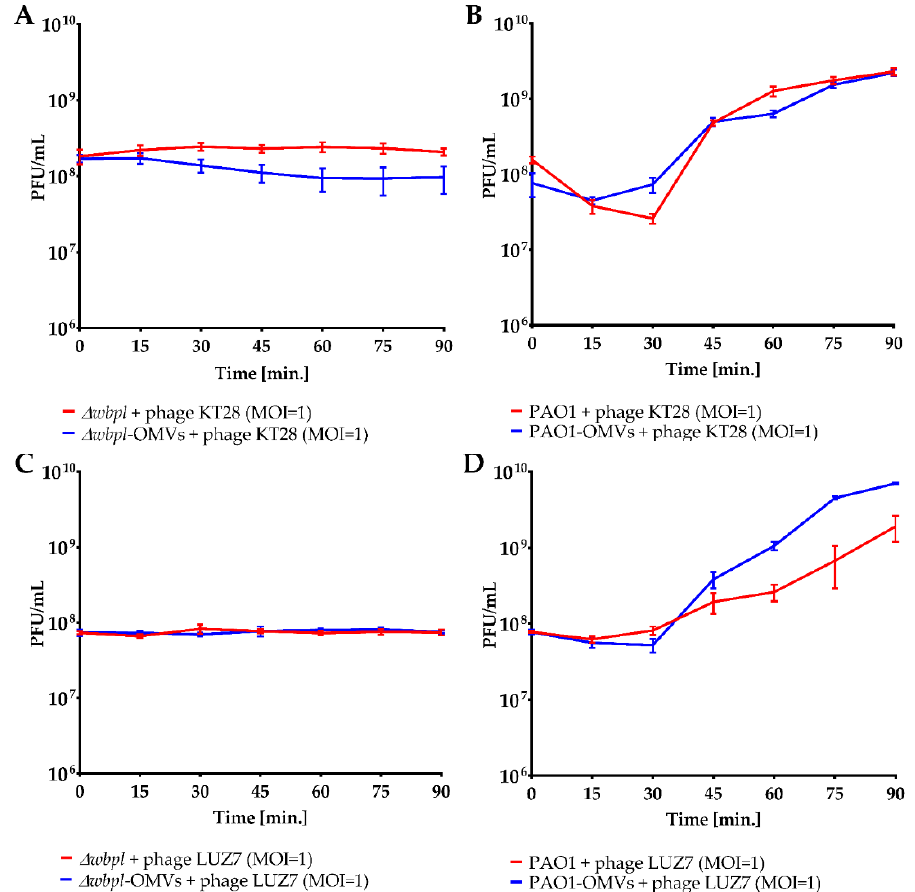
Figure 5. The OMVs association to P. aeruginosa cells as a potential sensitizer/disturbance agent to phage adsorption and propagation evaluated in a modified one-step growth cycle (MOI = 1). The PAO1 wild-type strain was used as the phage-sensitive host, whereas Δ wbpl knock-out mutant deficient in O-antigens served as the phage-resistant strain. Phage titre (PFU/mL) of myovirus KT28 ( A , B ) and podovirus LUZ7 ( C , D ) were determined every 15 min by the double-agar layer technique. The curves were established on the average of triplicate PFU/mL measurement from two independent experiments ±SEM bars.